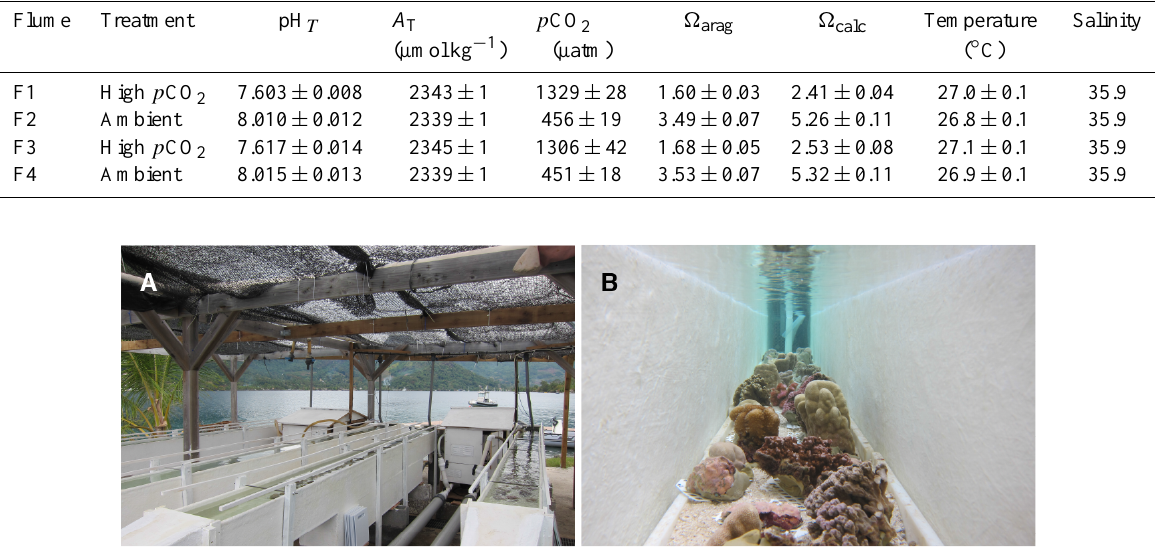
Figure 1. Photographs of the outdoor flumes. (a) The flumes consisted of a 5 . 00 × 0 . 30 × 0 . 30m working section and a lower sediment chamber (2 . 50 × 0 . 30 × 0 . 25m) in which sediments were maintained; together they contained ∼ 600L of seawater. (b) Communities matching the average composition (in 2013) of the back reef in Moorea were constructed in the